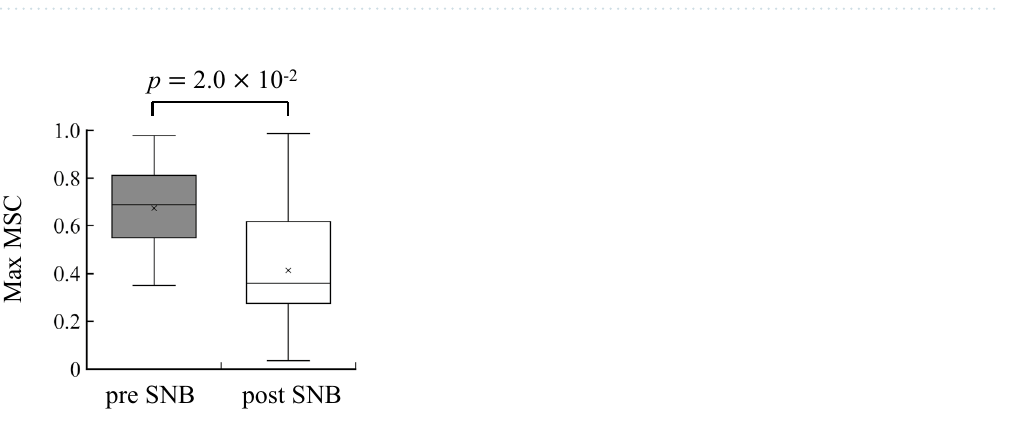
Figure 6. Averages of MSC between peripheral arterial stiffness β and SBP for all subjects: ( a ) pre SNB, ( b ) post SNB.